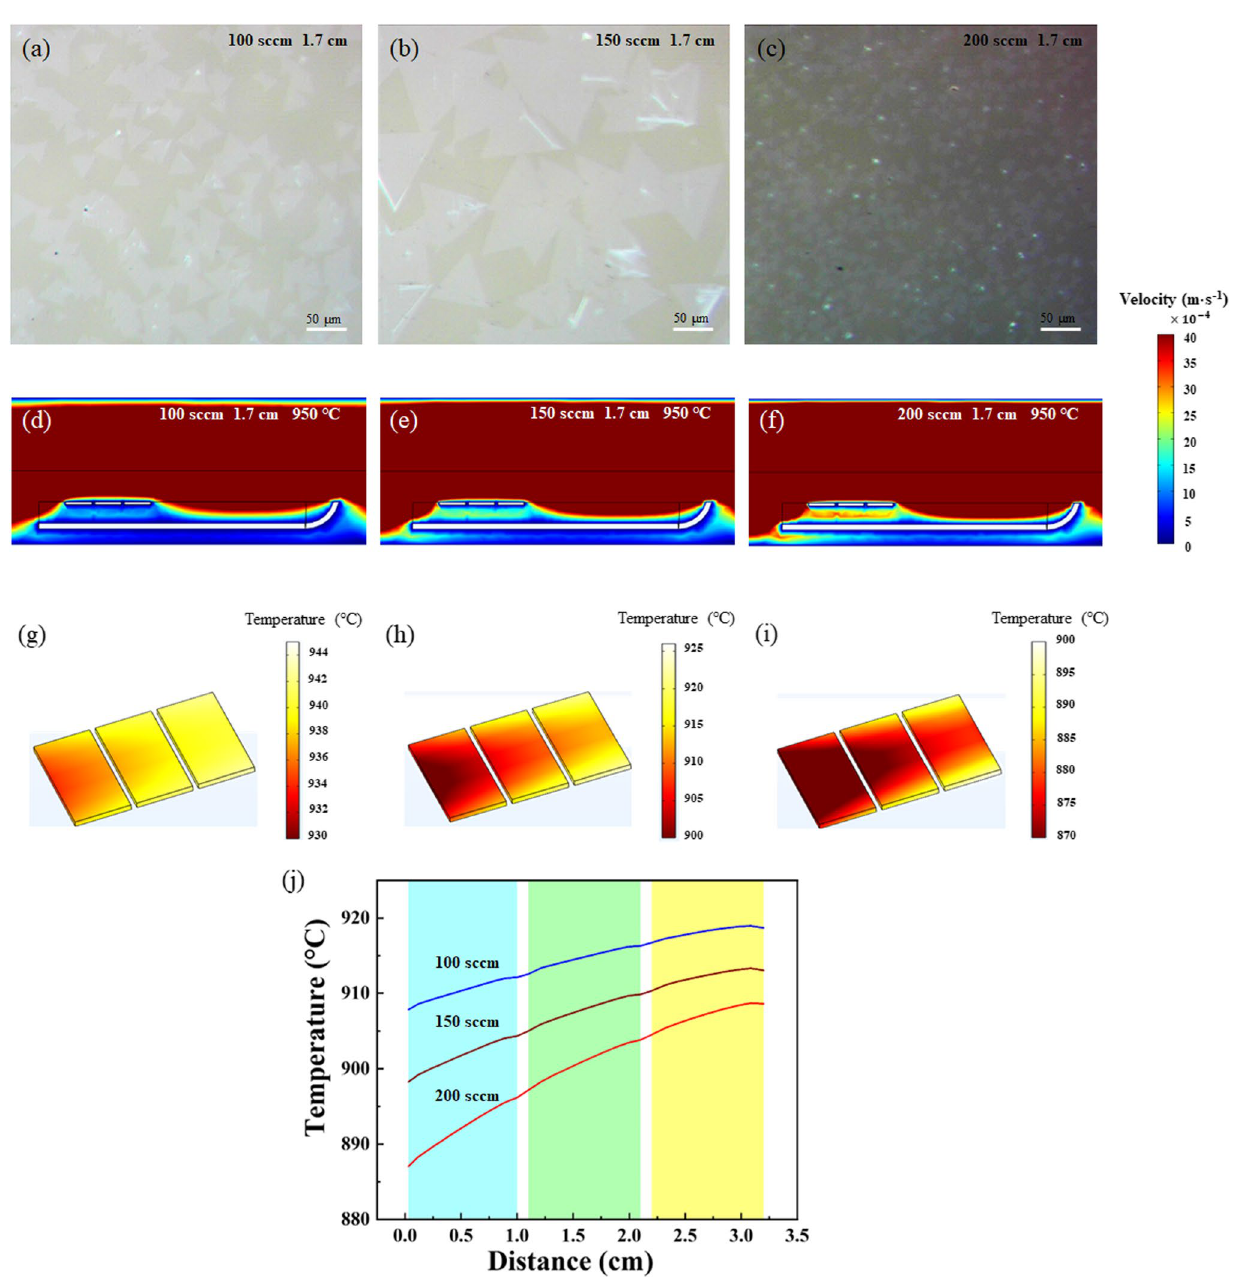
Fig. 2 a – c The optical images of WS samples grown on sapphire substrates at gas velocity of 100, 150, 200 sccm, respectively. COMSOL sim- 2 ulation of d – f gas and g – i temperature distribution around the three sapphire substrates in the front opening quartz at gas velocity of 100, 150, 200 sccm under fixed 950 °C, respectively. j The extracted temperature curves along the middle line of the three sapphire